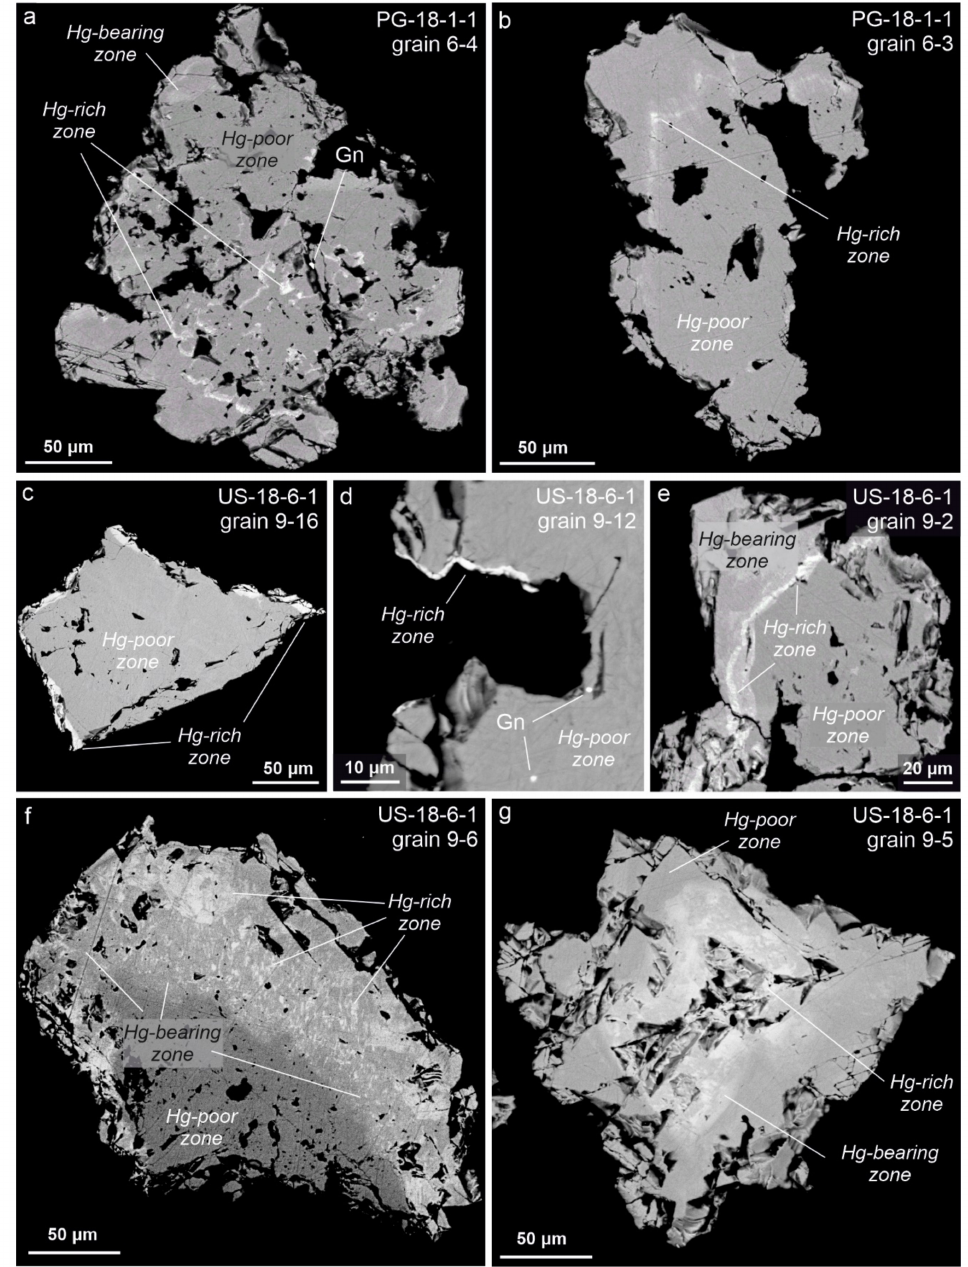
Figure 11. Back-scattered electron (BSE) images of mercury distribution in heterogeneous sphalerite. For specific Hg concentrations in sphalerites ( a , b , f , g ) see Tables 4 and 6. ( a , b , e ) wavy thin belts of high and moderate Hg contents in a Hg-poorer matrix. ( c,d ) Hg-poor sphalerite grain decorated by later Hg-rich rim. ( f ) mottled textures between Hg-rich and Hg-bearing clots in the Hg-enriched wide rim. ( e ) oscillatory zoning of Hg in sphalerite twin with high-Hg